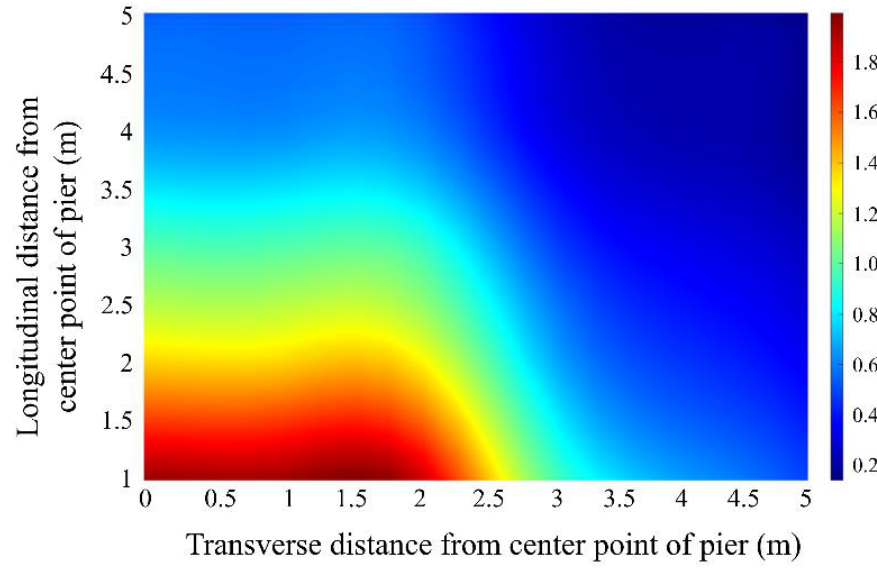
Figure 20. Pier deformation under temporary load at different positions (cm).